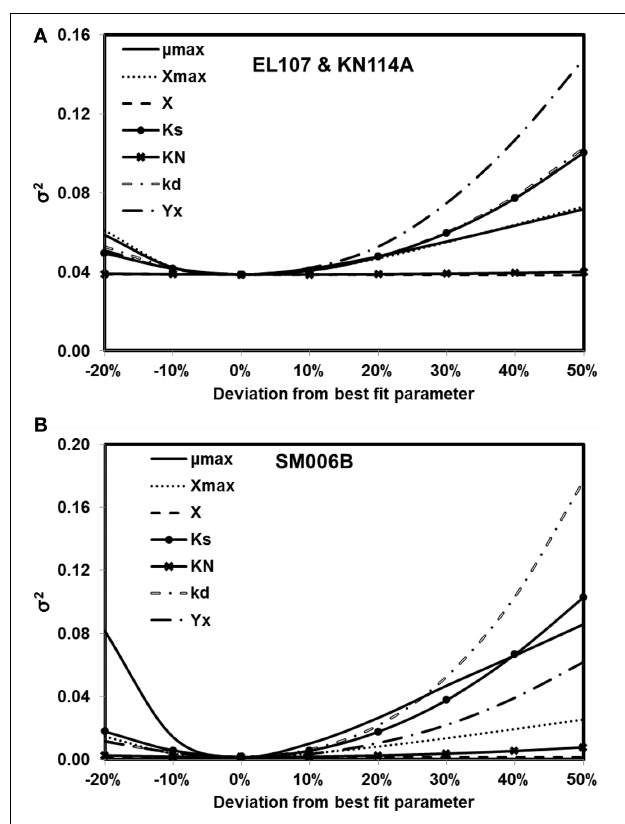
FIGURE 4 | Sensitivity analysis for kinetic parameter estimates for (A) EL107 and KN114A (B) SM006B. Note that the minimum value of the variance of errors is at 0% deviation (i.e., estimated